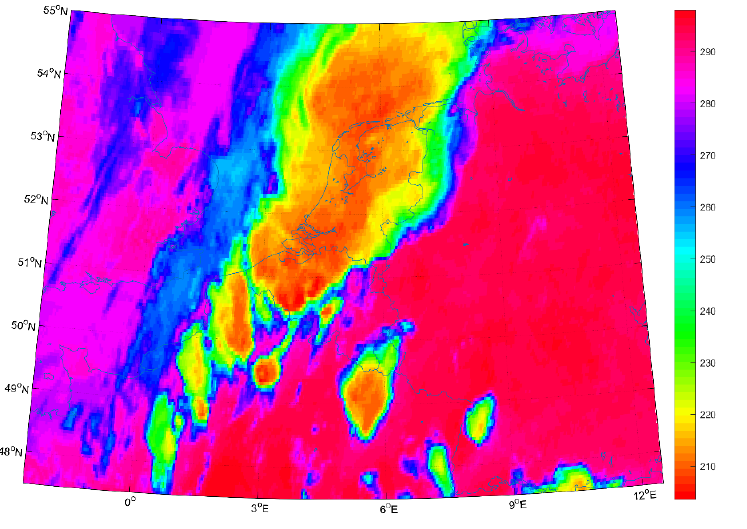
Figure 4. OPERA Radars quality index. 5 June 2015 17:30.